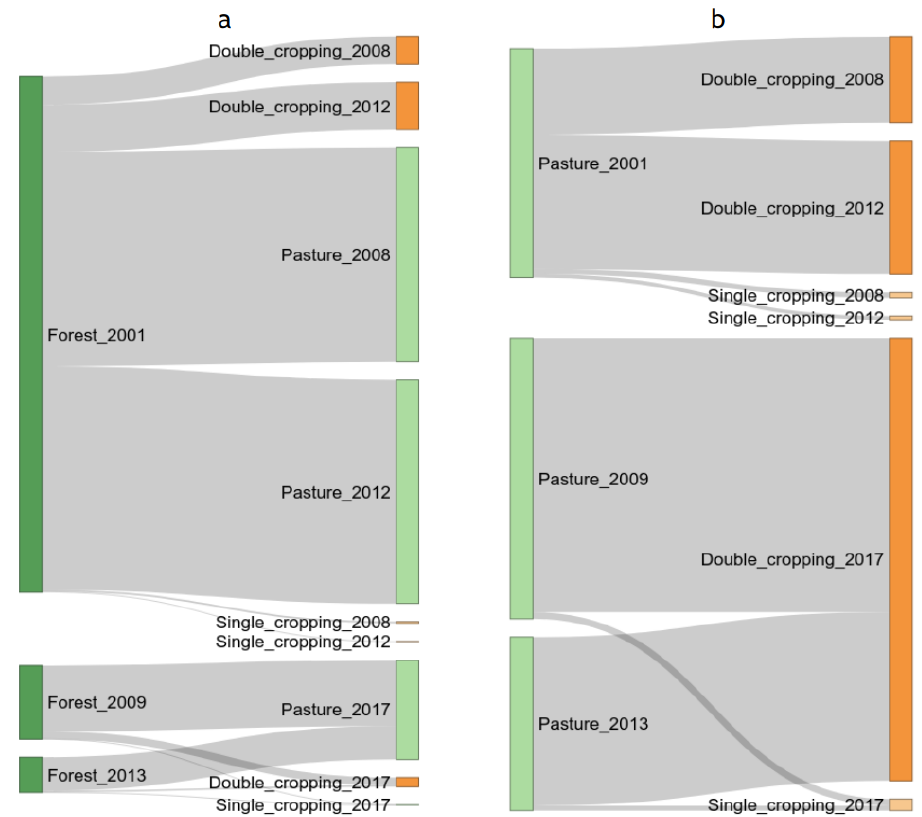
Figure 6. Amazon biome: ( a ) conversion of Forest to Agriculture (single and double crop) and Pasture and ( b ) conversion from Pasture to Cropping in the three studied